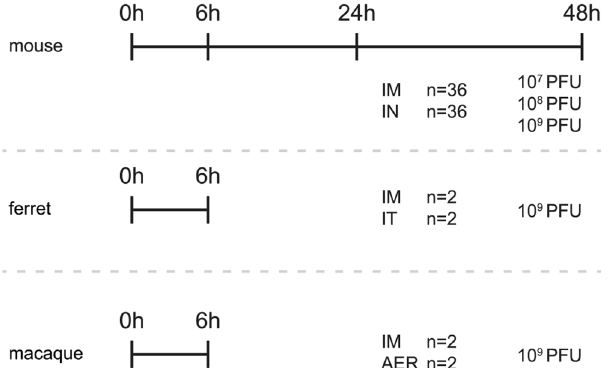
Figure 2. Experimental setup of rMVA-GFP in vivo studies. Three different doses (10 7 –10 9 PFU) of rMVA- GFP were administered to mice via IM injection or IN instillation. At 6, 24 or 48 HPA, mice were euthanized. Ferrets and macaques received 10 9 rMVA-GFP via IM injection or direct respiratory tract administration (IT inoculation for ferrets, AER inhalation for macaques) and were euthanized 6